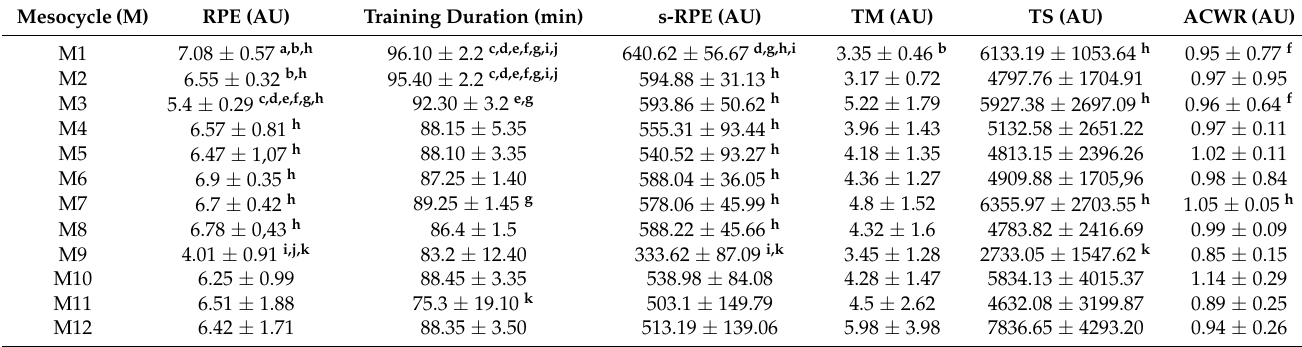
Table 2. Training load data during the 12 mesocycles for squad average, Mean ±